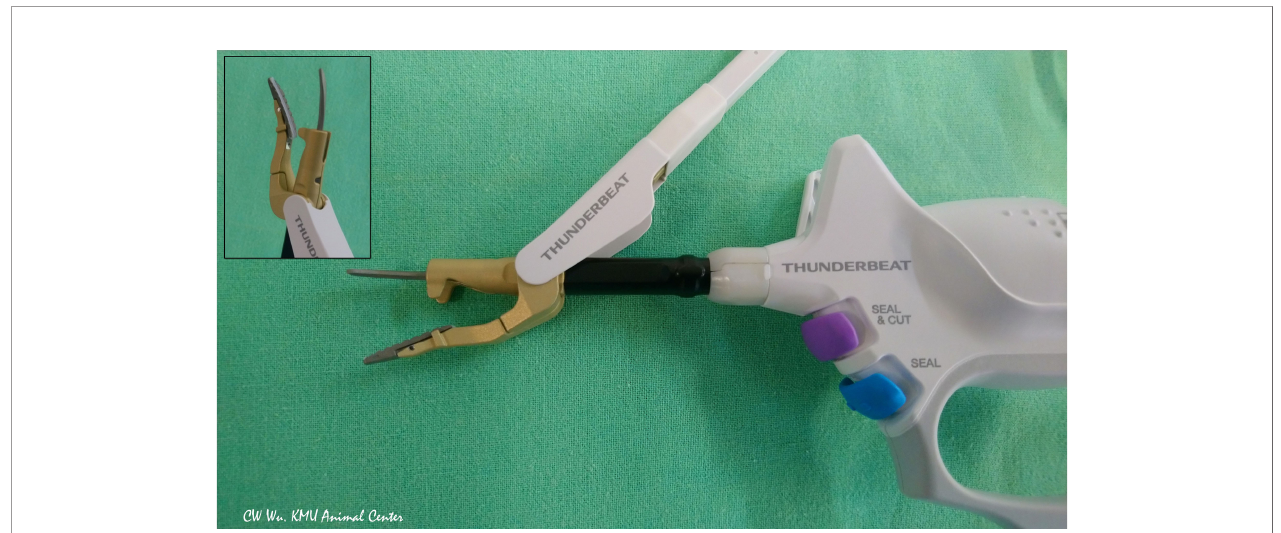
FIGURE 5 | Hybrid energy based device (ultrasonic and bipolar energy). The Thunderbeat Open Fine Jaw (TB; Olympus Co Inc, Tokyo, Japan) has a thin, curved probe for fi ne dissection. The counter jaw enables its use for grasping tissue. The aluminum coating dissipates residual